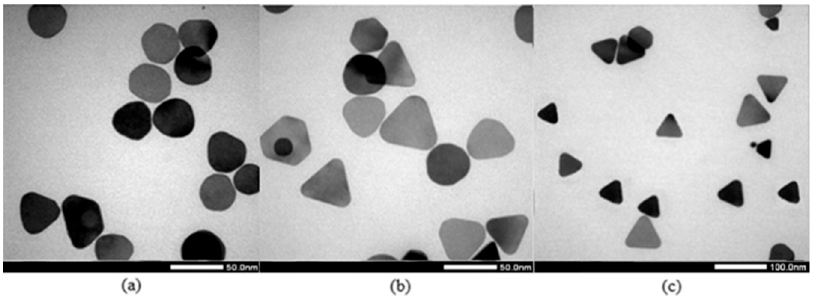
Figure 4. TEM images of ( a ) nano disk shapes (scale 50 nm) (G + CHI 0%, w/v); ( b ) hexagonal (30%) and triangular shapes (50%) (scale 50 nm) (G + CHI 0.5 + 0.06%, w/v); and ( c ) high yield of triangular shapes of AgNPs (70%) (scale 100 nm) (G + CHI 0.2 + 0.06%).